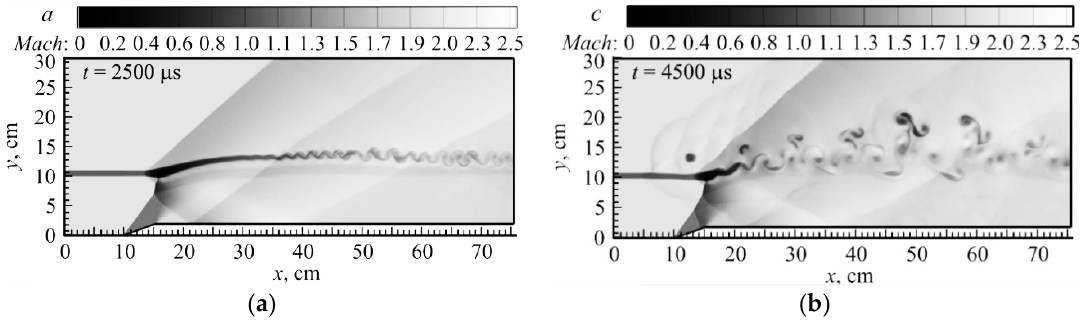
Figure 20. Result of simulation [124]: Richtmyer–Meshkov instability intensification by pulse-periodic heat source: ( a ) no heat source; ( b ) heat source on at x = 13 cm, y = 13 cm. Reprinted from [124] with permission from authors.